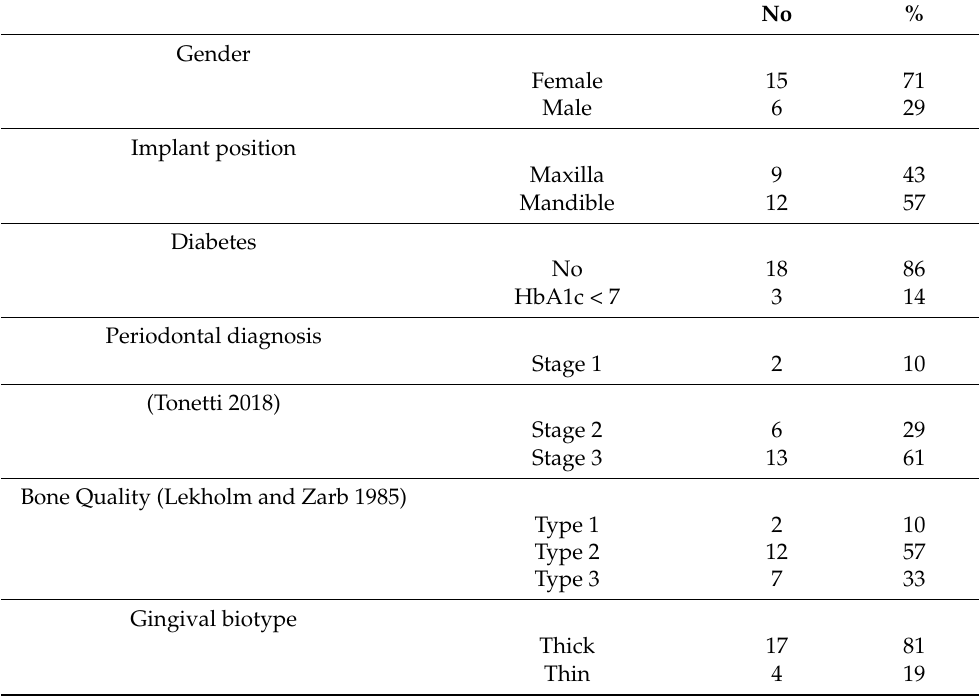
Table 2. Included patients and